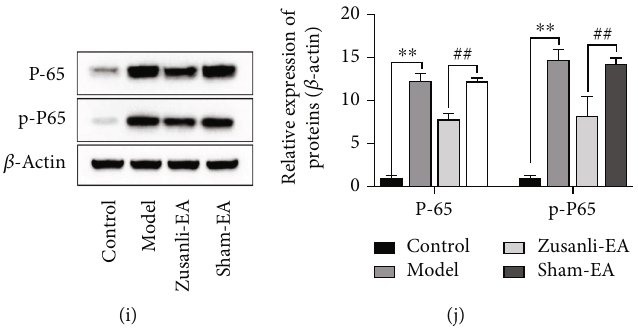
Figure 5: EA inhibited TRPV1/CGRP, ERK, and TLR4 signaling pathways in DSS-induced colitis rats. Representative Western blot analysis and quanti fi cation of densitometries of Western blot band for the expression of TRPV1 and CGRP (a, b), MEK and p-MEK (c, d), CREB and p-CREB (e, f), TLR4, IRF3, and p-IRF3 (g, h), and P-65 and p-P65 (i, j) in L6 DRG of DSS-induced colitis rats. β -Actin was used as a loading control. ∗∗ P < 0 : 01 vs. control group, ## P < 0 : 01 vs. sham-EA group. Data represents means ± SD